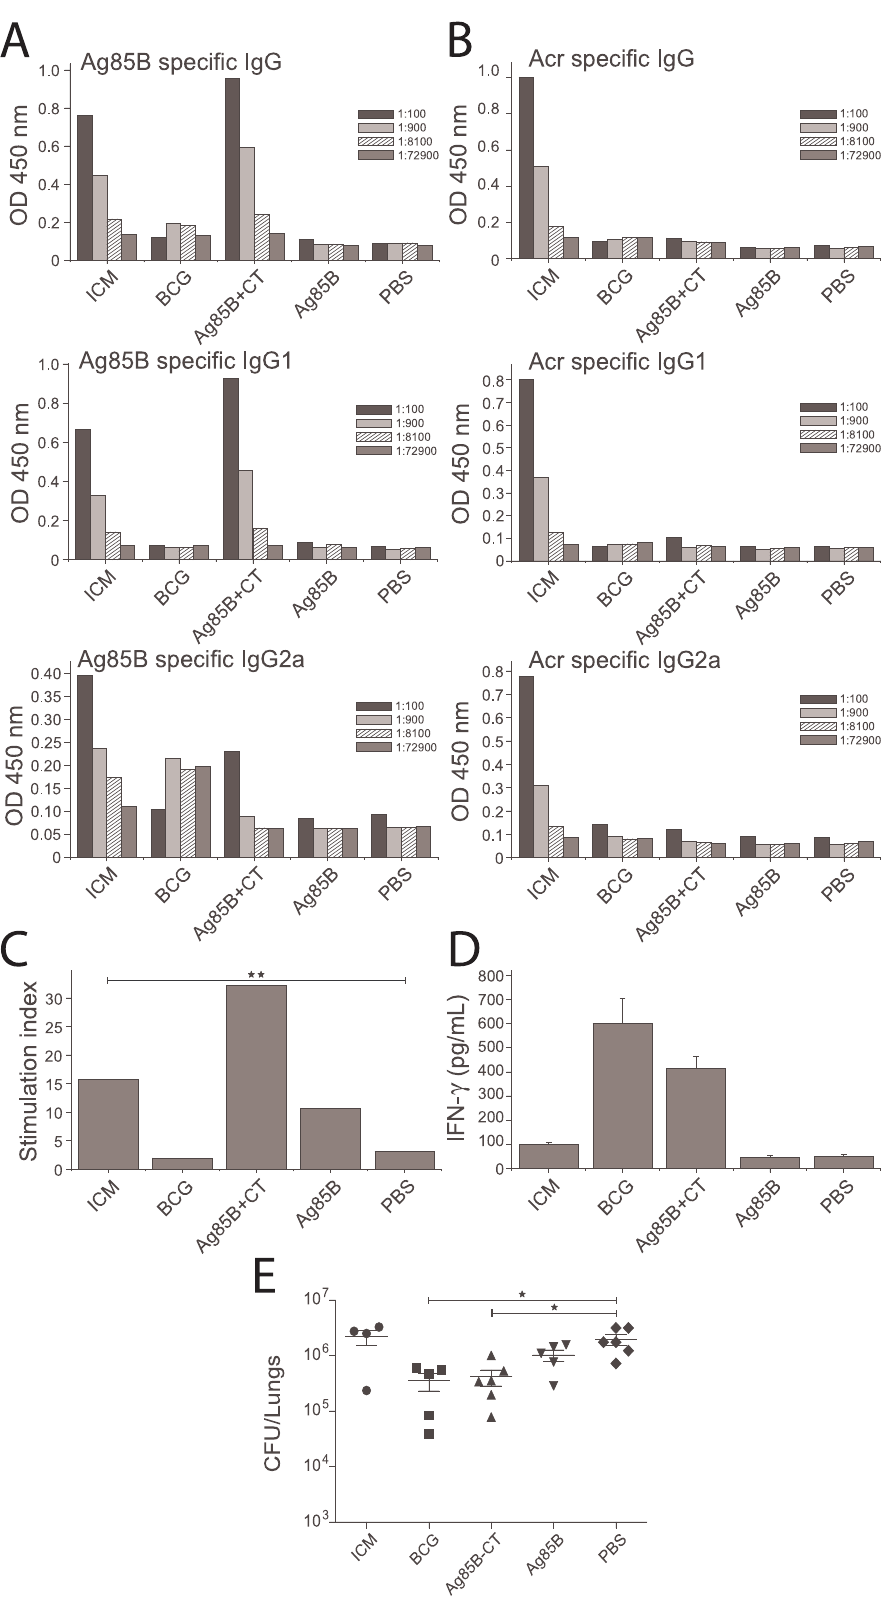
Figure 4. Immune responses and MTB bacterial counts in mice immunised with ICM. Mice were immunised with 50 m g ICM (1:20 antibody antigen ratio) or with Ag85B alone (30 m g), Ag85B + CT, BCG and PBS; two weeks after the final immunisation mice were either culled and their tissues (blood and spleens) used for immunological evaluation, or challenged i.n. with 70,000 MTB H37Rv. * Indicates statistically significant difference